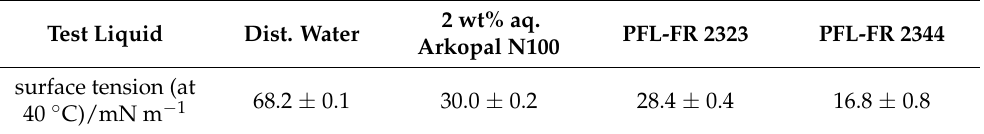
Table 3. Surface tension between the test liquid and the gas phase at 40 ◦ C measured by the Wilhelmy plate method in mN m − 1